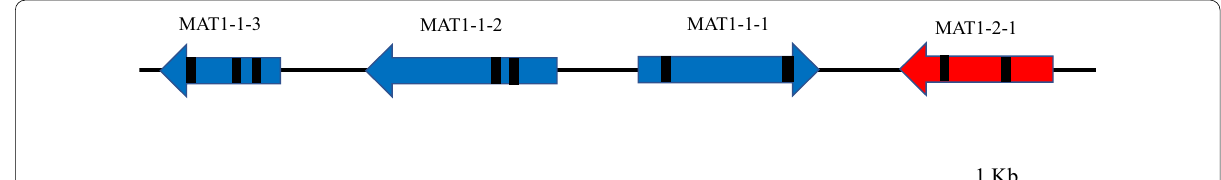
Fig. 4 MAT1 locus of Immersiporthe knoxdaviesiana predicted by AUGUSTUS v. 3.3.3. Predicted introns were denoted by black